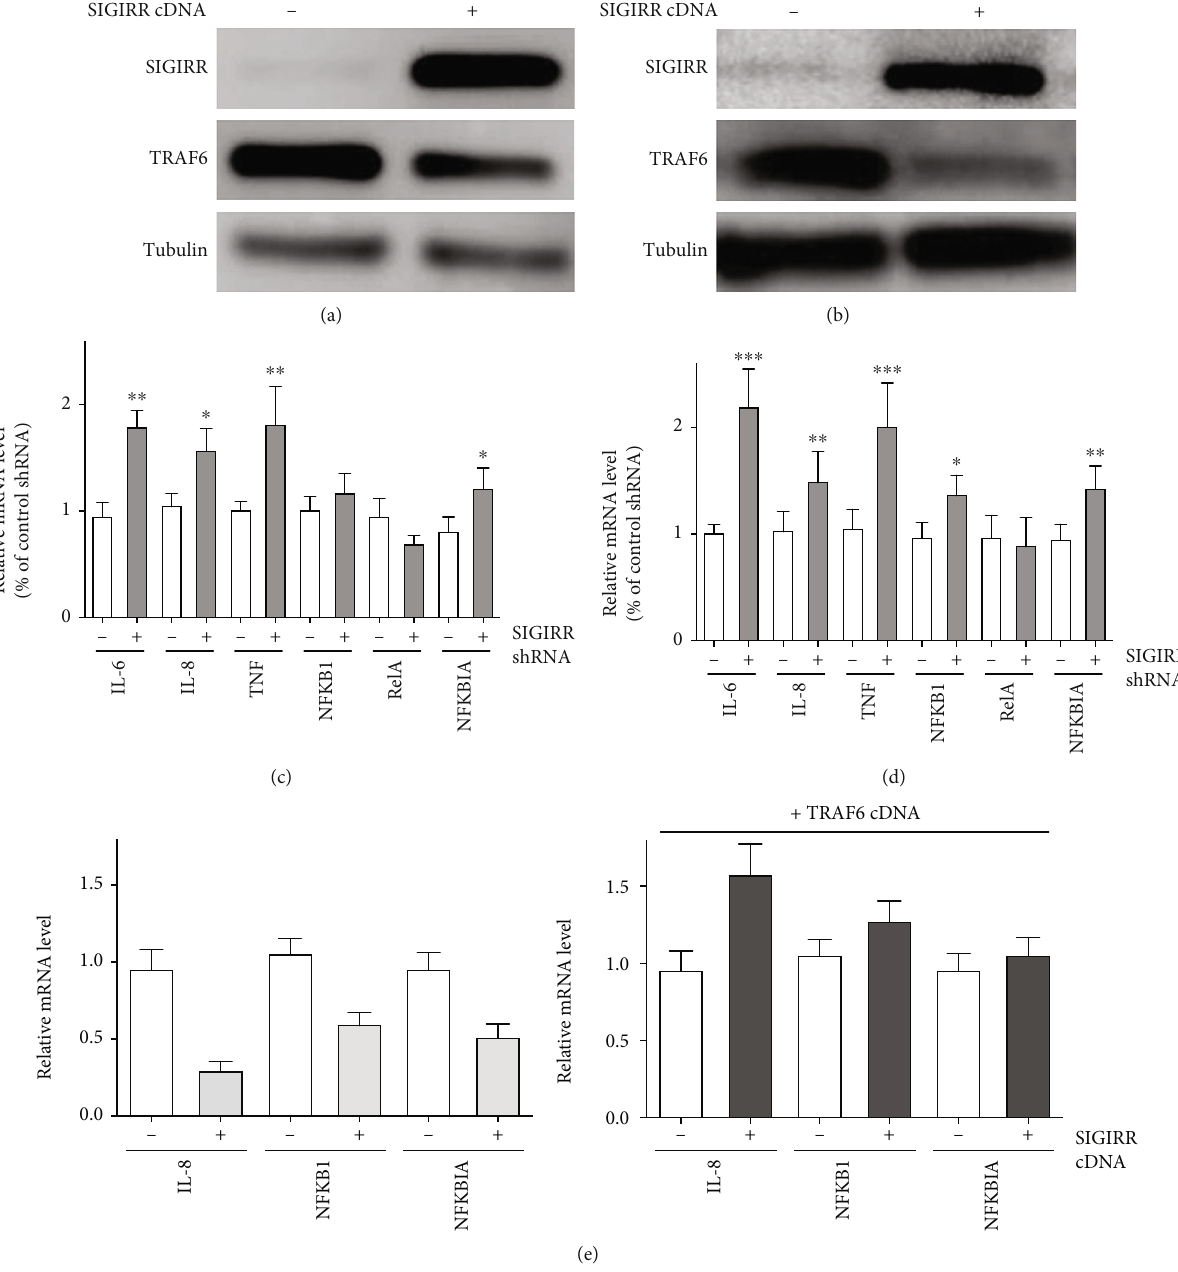
Figure 3: E ff ect of TRAF6 reversal of SIGIRR in AMCs. (a, b) SIGIRR overexpression was performed to detect changes on SIGIRR and TRAF6 in AECs and AMCs. (c, d) The mRNA levels of downstream NF- κ B signaling molecules, including IL-6, IL-8, TNF- α , NFKBIA, NFKB1, and RelA, were observed in the presence or absence of SIGIRR_shRNA in AECs and AMCs. (e) The rescue experiments were performed by cotransfection with TRAF6_cDNA and SIGIRR_shRNA in AMCs. The data represent three independent experiments with four samples for each treatment. ∗∗ P < 0 : 01 and ∗∗∗ P < 0 : 001